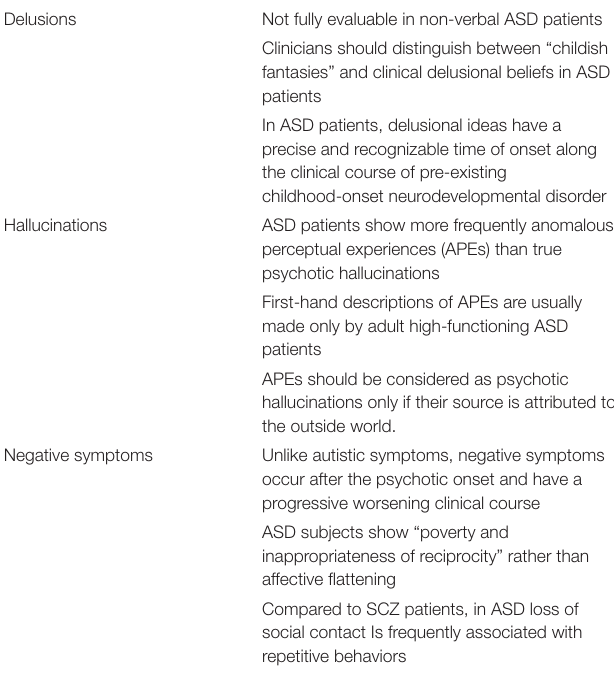
TABLE 2 | Basic differences between ASD and SCZ patients for the detection of delusions, hallucinations, and negative symptoms.